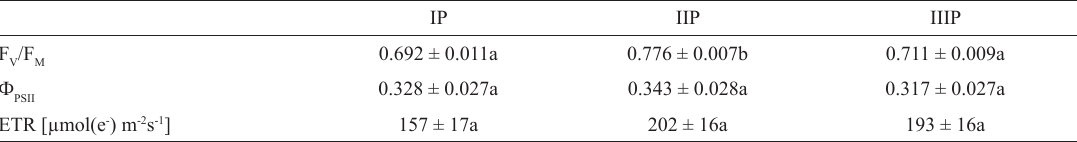
Table 3. Values of fluorescence-based maximum quantum yield of PSII photochemistry (F yield of PSII photochemistry (ɸ ) and electron transport rate [ETR, µmol(e - ) m -2 s -1 ] in the three phases PSII considered during leaf development in Corylus . IP = first phase at developing leaf; IIP = second phase at fully developed leaf; IIIP = third phase at leaf senescence. Different letters indicate significant differences (ANOVA, p ≤ 0.05) among the three phases. Mean values (± SE) are shown (n =